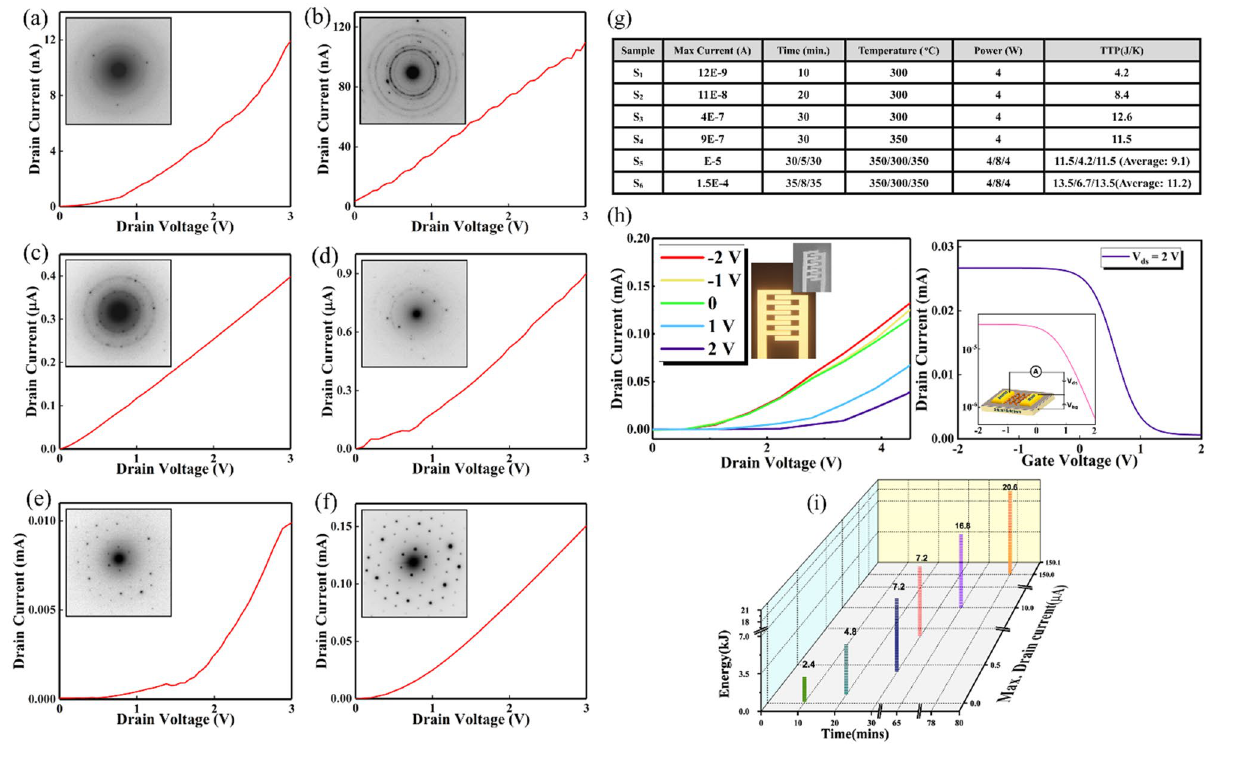
Figure 2. Electrical characteristics of phosphorene sheets: ( a-f ) Recorded currents of six different phosphorene- based resistors for different states of the crystallinity of synthesized sheets; from a partial crystal sample to a highly crystalline one. ( g ) Sample parameters of the different hydrogen plasma treatments. ( h ) Left: The output characteristic of a phosphorene-based field-effect transistor. Right: The linear and semi-log transfer curves. ( i ) A comprehensive correlation between the recorded current and the different process parameters (time and imparted